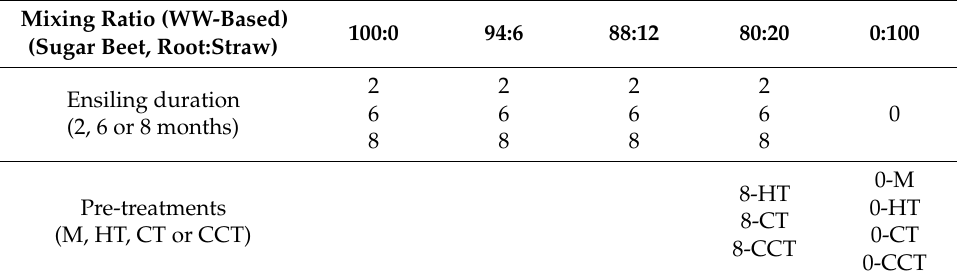
Table 1. Overview of samples and their respective types of